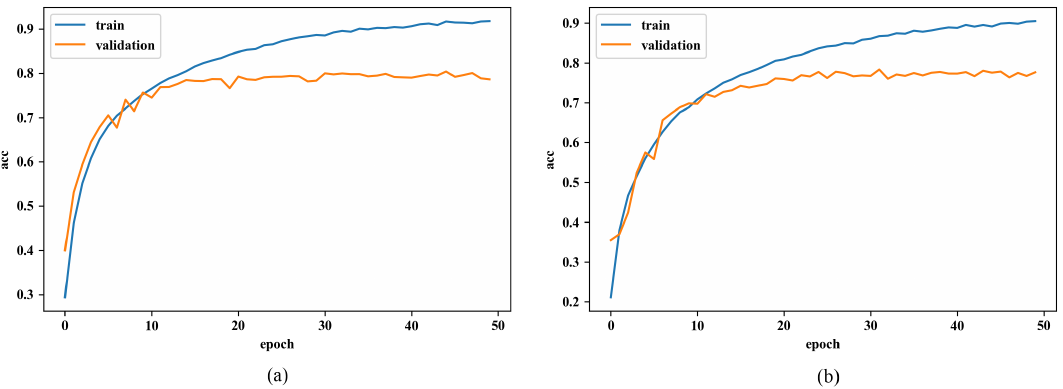
Figure 7. Learning curve under the whole dataset ( a ) using normal initialization, and ( b ) using RGB-based